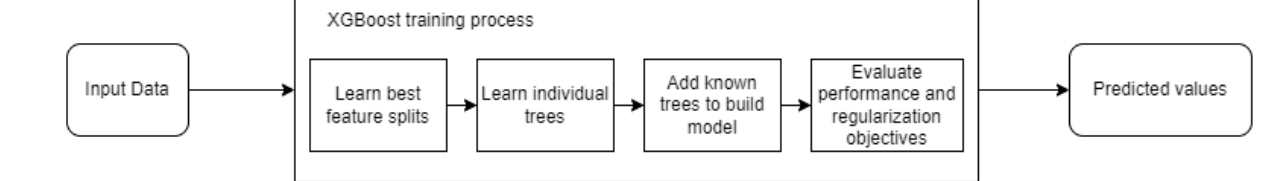
Figure 4. XGBoost training process.